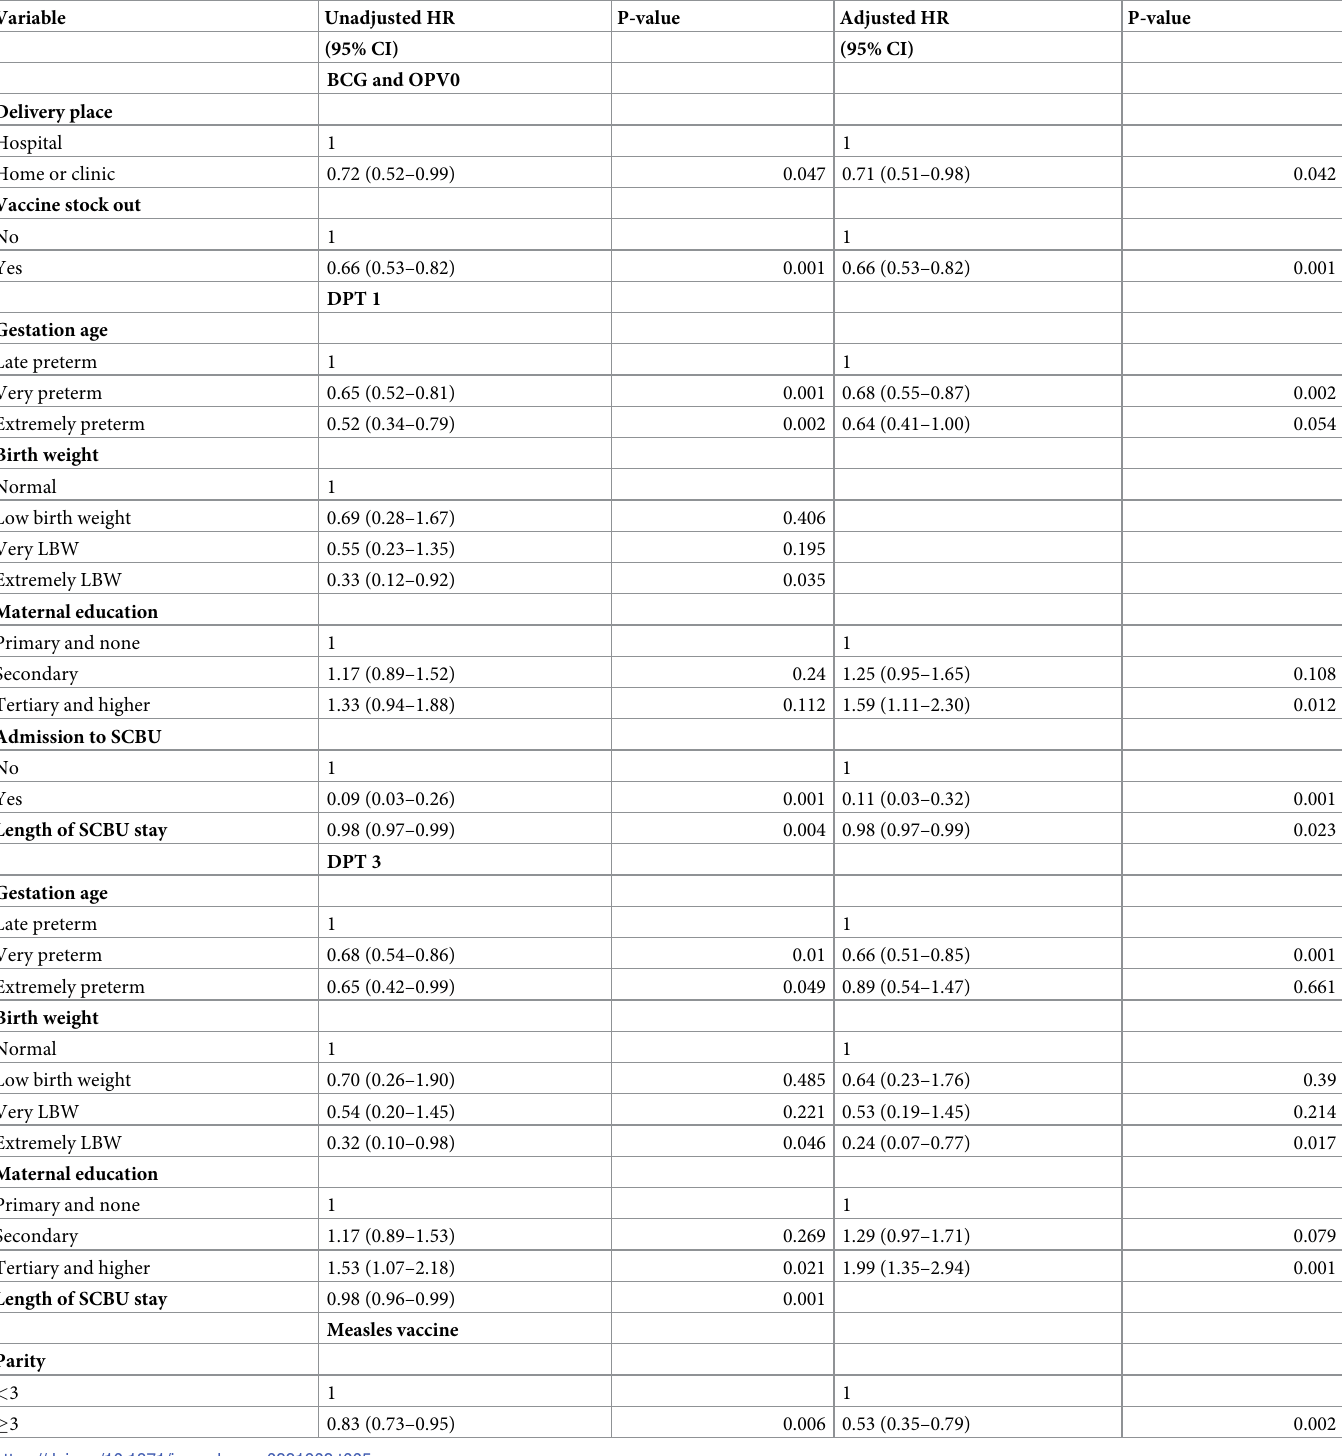
Table 5. Factors associated with untimely vaccination of preterm infants aged 6–24 months at Mulago Hospital, Kampala,